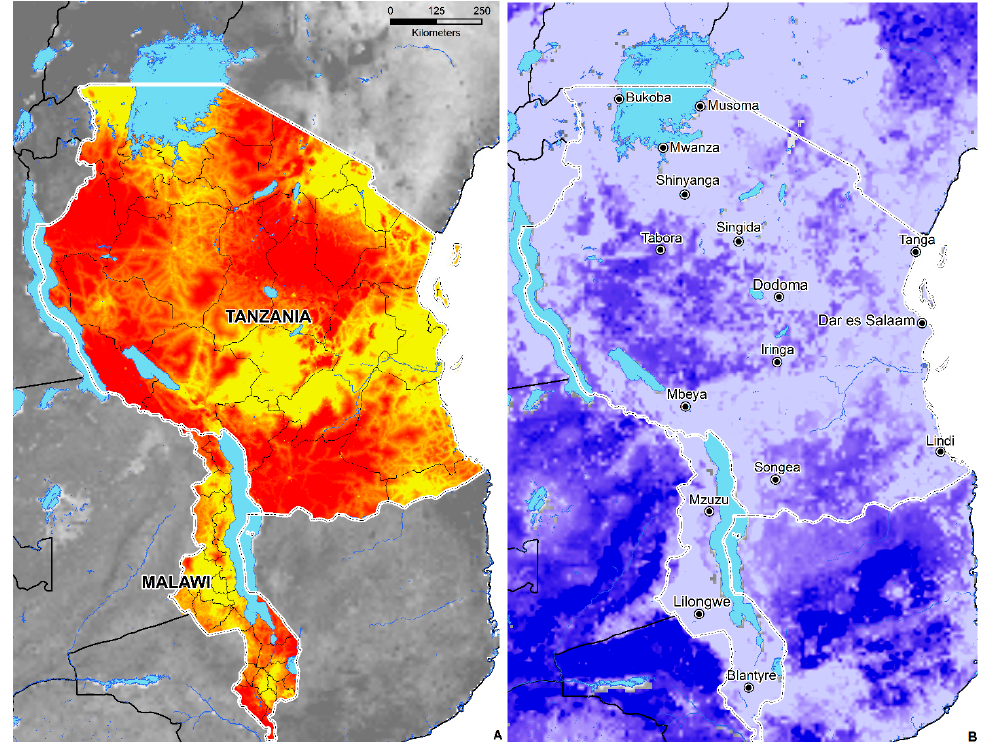
Figure 7. (A ) The proportion of people living on $1.25 a day in Tanzania and Malawi. Red corresponds to a higher proportion of the population living on $1.25 a day; yellow represents a lower proportion of the population living on $1.25 a day. ( B ) The coefficient of variation (CV) or measure of model uncertainty. Lighter colors = less uncertainty; darker colors = increased uncertainty.